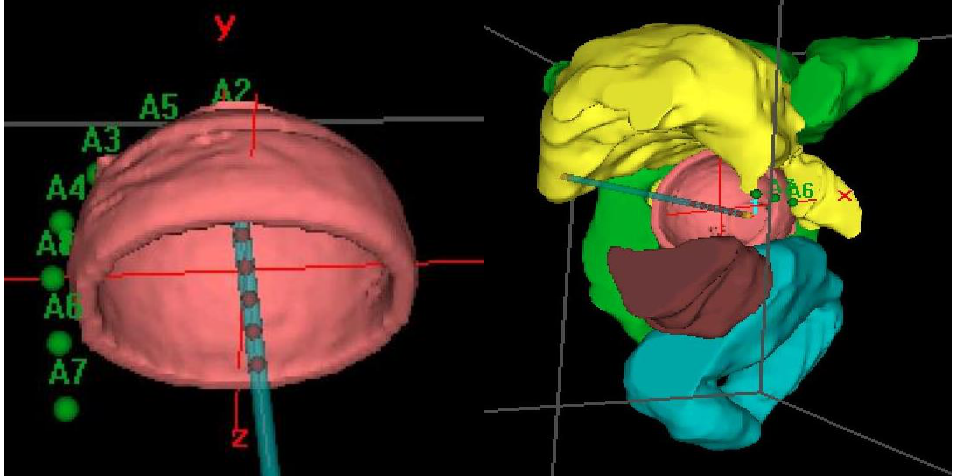
Figure 2. Clinical target Volume (CTV) and Organs at risk (OAR) delineation.